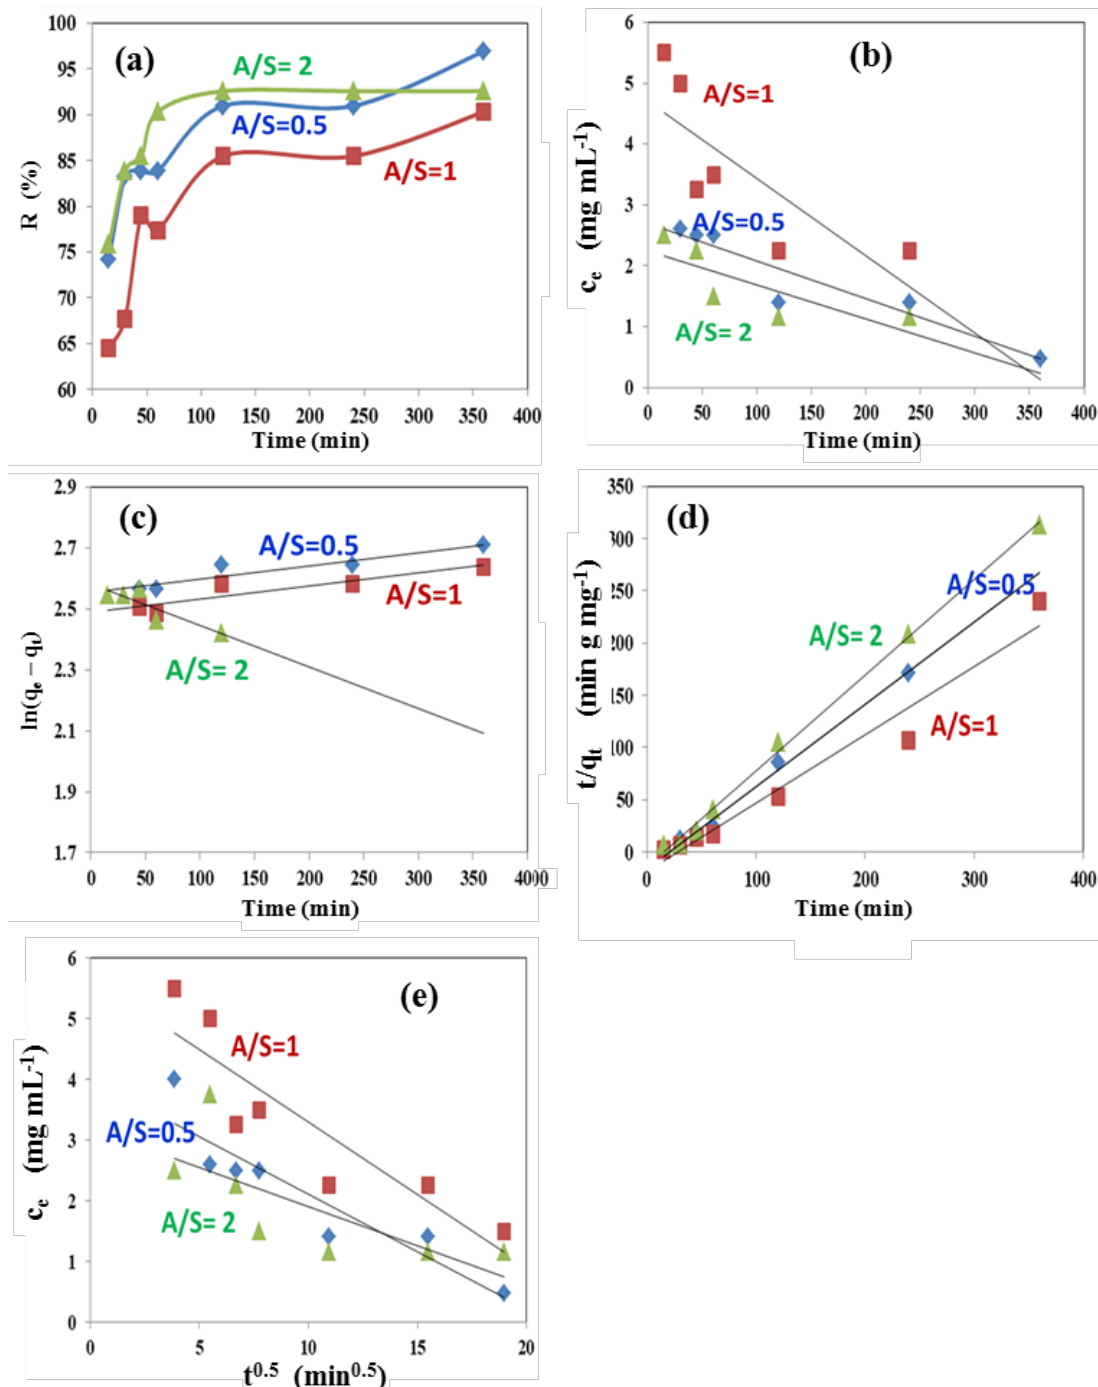
Figure 10. ( a ) Effect of contact time, ( b ) fit (zero-order reaction), ( c ) pseudo-first-order rate, ( d ) pseudo-second-order rate, and ( e ) intra-particle diffusion. Kinetics fits were tested in order to elucidate the mechanism of Cr(VI) adsorption (see Figure 10b–d and fit parameters in Table 4): Pseudo-second-order kinetics best described the process, indicating the importance of coordination bond formation between Cr(IV) and the gel (especially with the AM units that favored more efficient adsorption in Figure